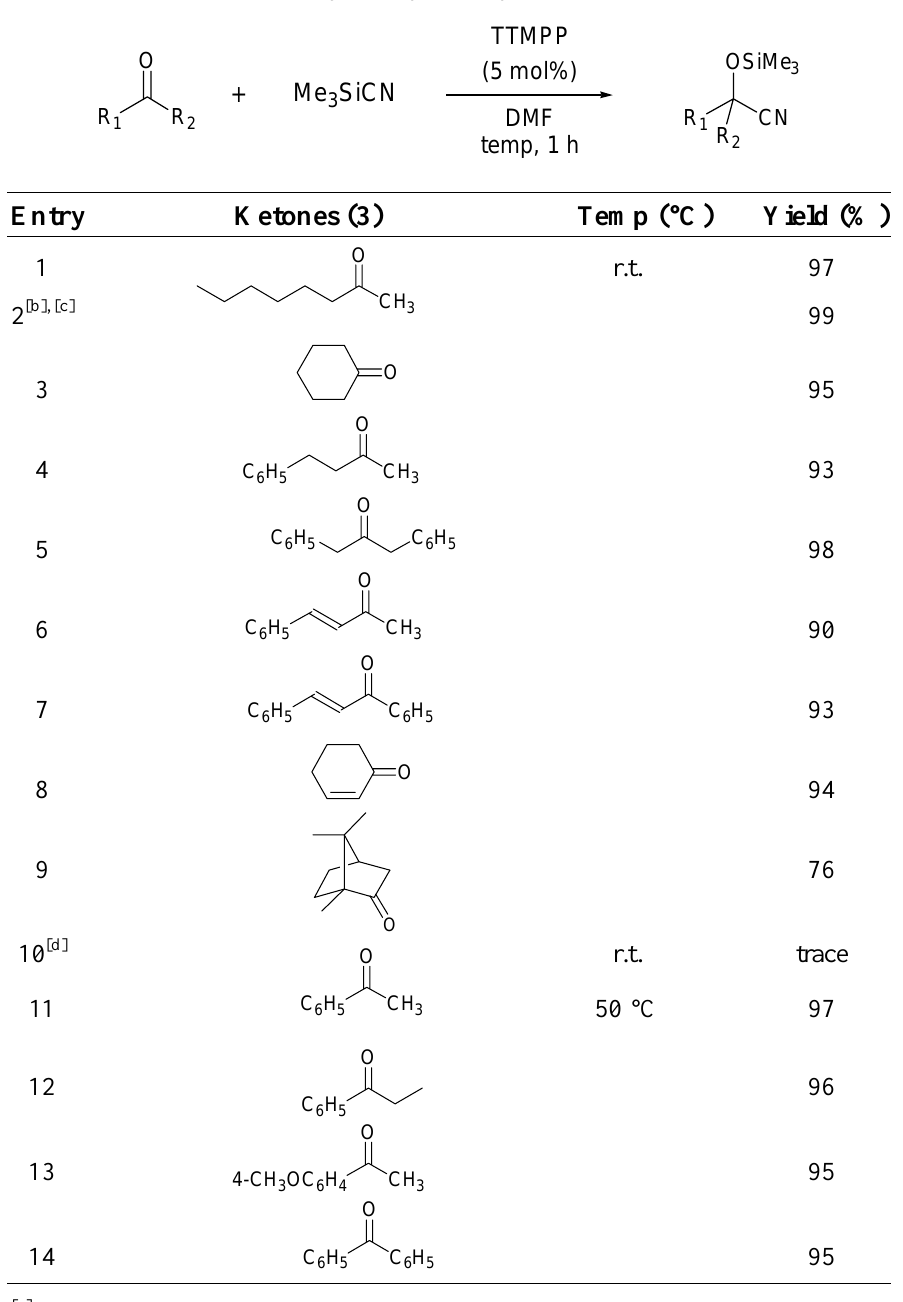
Table 2. TTMPP-Catalyzed cyanosilylation of various ketones. [a]